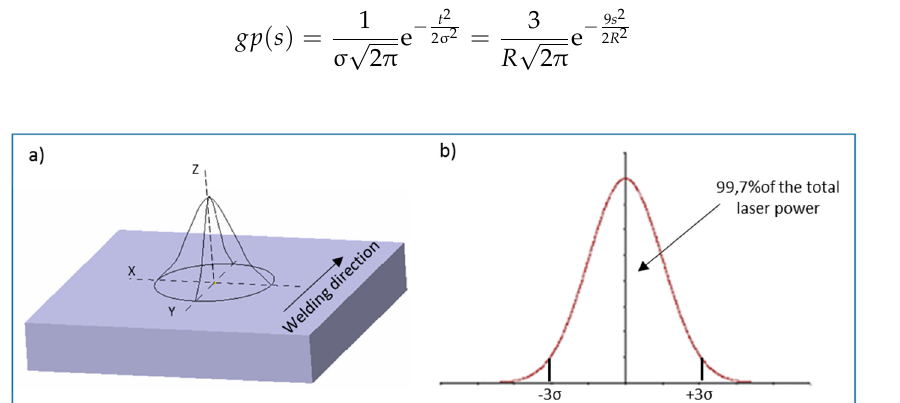
Figure 3. ( a ) Combining of the two Gaussian distribution in plane XZ and XY , and ( b ) Gaussian distribution.